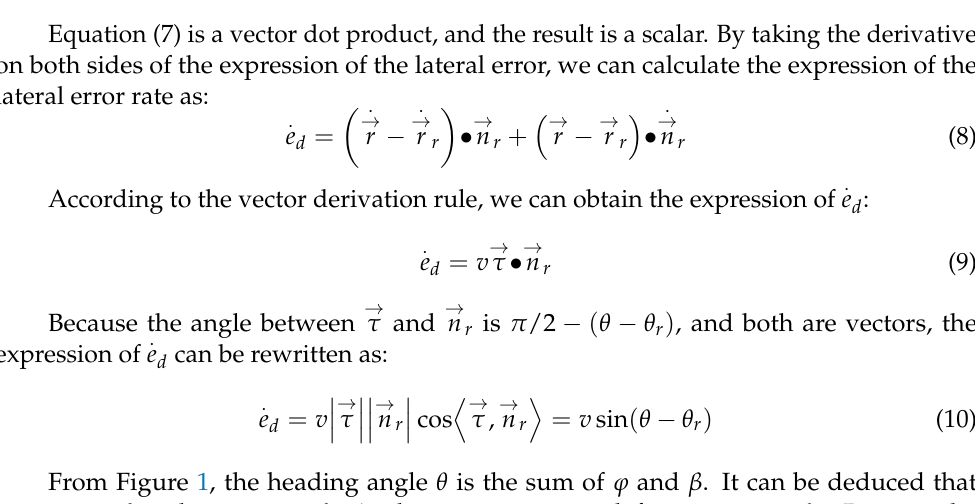
Figure 3. The later deviation between the current position and the desired